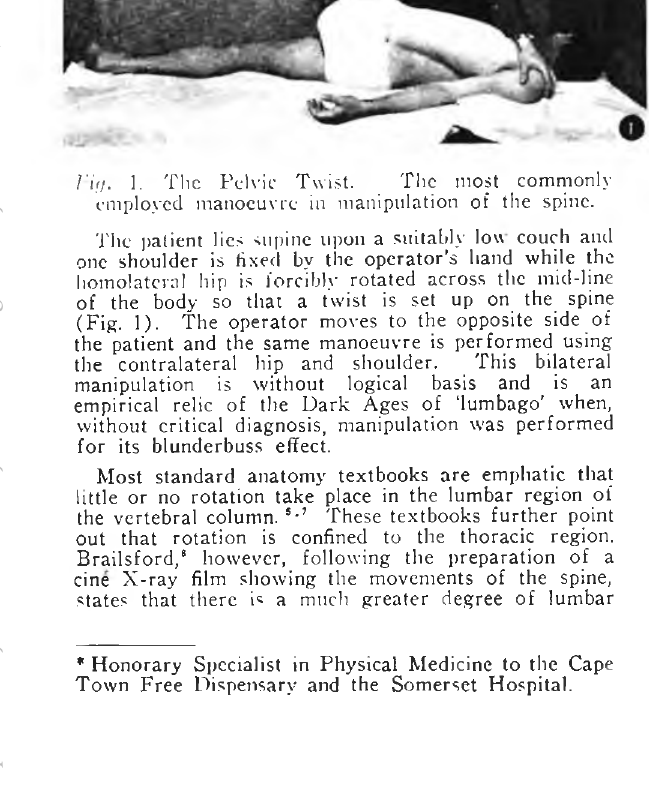
Fig. 3 represents the A-P view of the lumbar spine of a female dancer of 16 years. There is considerably more rotation than in the previous